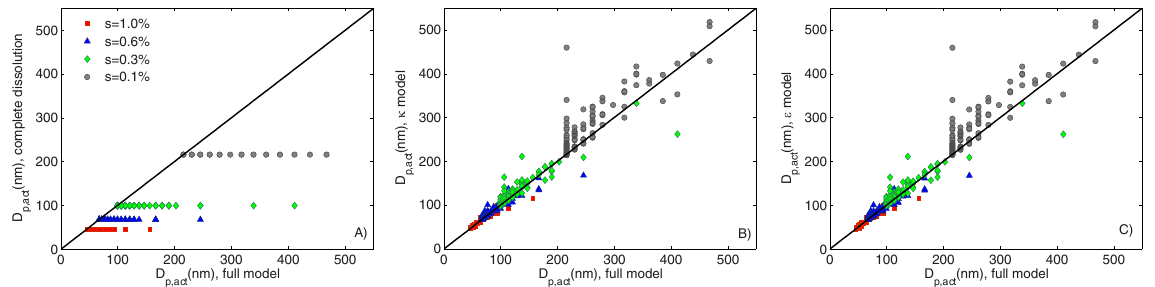
Figure 5. The activation diameter calculated using the solubility distributions (Table 2, referred to as the full model) and the simplified dissolution descriptions (Table 1): (a) complete dissolution assumption; (b) the hygroscopicity parameter κ ; and (c) the soluble fraction ε eff to describe the solubility of the organic mixture. The symbols correspond to the best fits to the full model data. The black line shows the 1:1 correspondence between the two data sets.